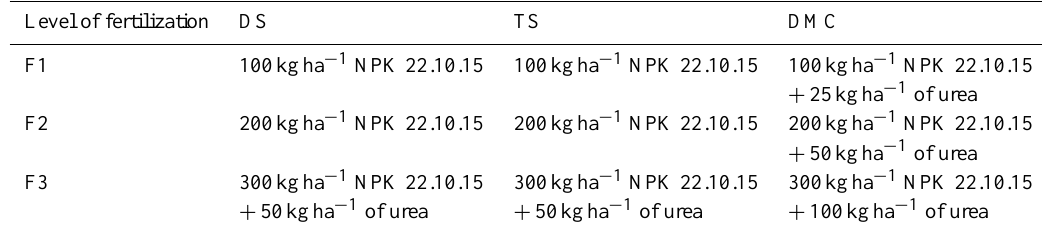
Table 1. Different levels of fertilization (source: SODECOTON